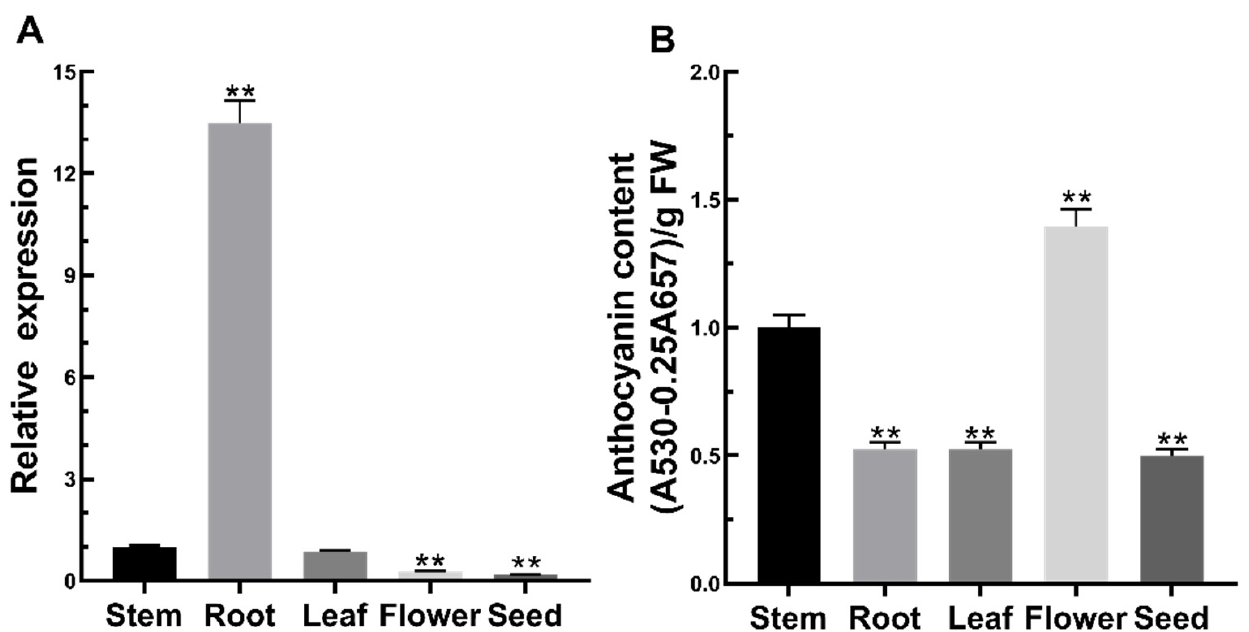
Figure 2. The transcription level of FtMYB3 and anthocyanin content in different organs. Tartary buckwheat roots, stems, leaves, flowers, and seeds were collected at 40 days after sowing for the analysis of gene expression pattern and the determination of anthocyanin content. ( A ) FtMYB3 expression level in different organs; ( B ) Anthocyanin content in various organs. The accumulation of anthocyanin content and gene expression level in stems are defined as “1”. ** means extremely significant difference at p < 0.01 level; Error bars reflect ± SDs.